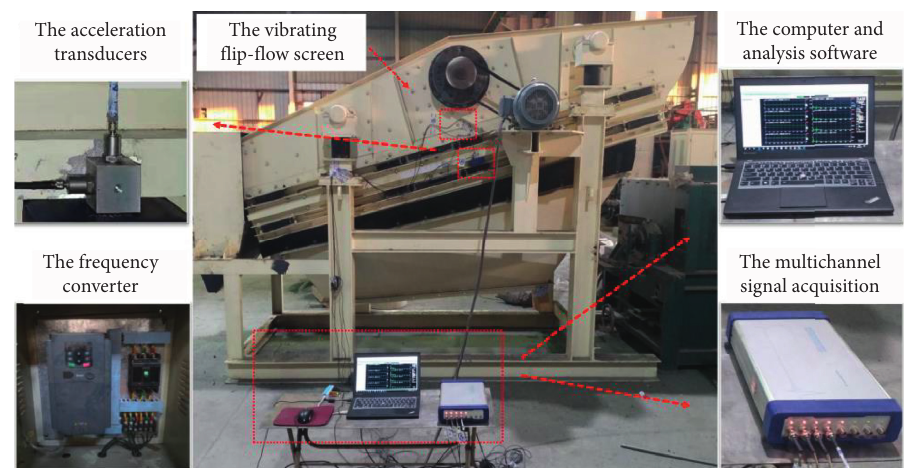
Figure 3: Schematic diagram of VFFS and the vibration test